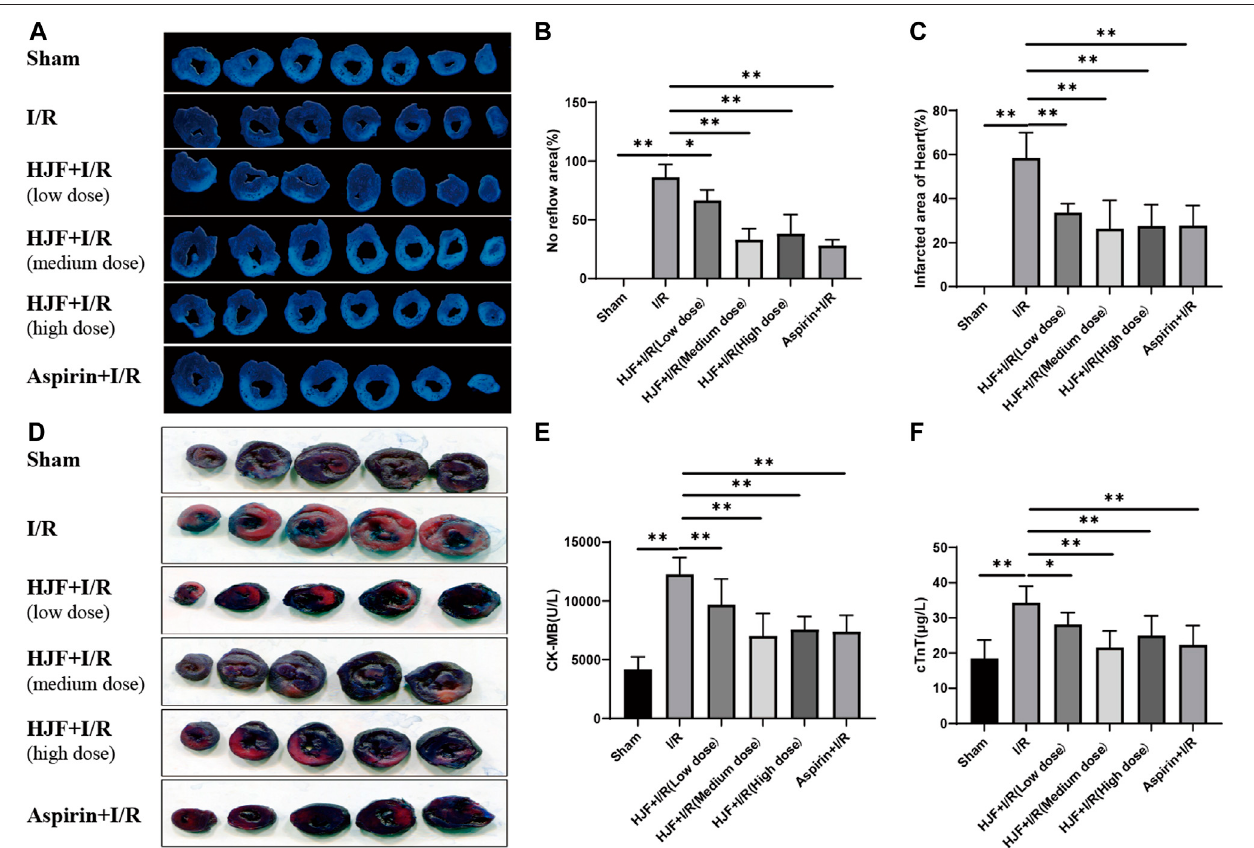
FIGURE1| HJFtreatment decreasedmyocardialinjuryinducedbyI/Rinrats. (A) ,Representativeimagesofnitrotetrazoliumbluechloridestainingoftheheart; (B) , Nore fl owareaoftheheart(n (cid:1) 3); (C) ,Infarctedareaoftheheart(n (cid:1) 3); (D) ,Representativeimagesofthio fl avinSstainingoftheheart; (E) ,SerumlevelofCK-MB(n (cid:1) 6); (F) , Serum level of cTnT (n (cid:1) 6). The data are shown as the means ± SDs in each group. * p < 0.05, ** p < 0.01. I/R, ischaemia/reperfusion; HJF, Huoxue Jiedu Formula; CK-MB, creatine kinase isoenzyme MB; c-TnT, cardiac troponin